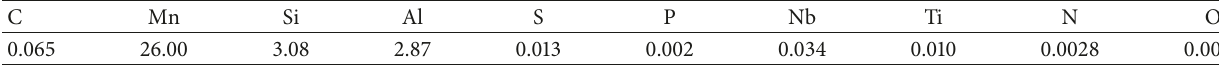
Table 1: Chemical composition of the investigated steel (wt.%).